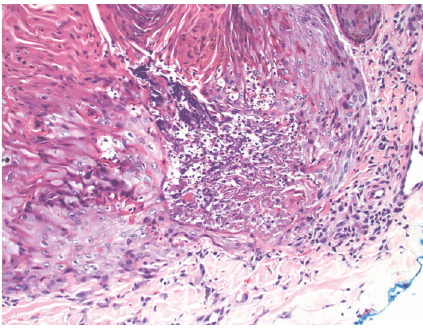
Figure 4: High magnification of the base of the defect showing perforation through the epidermis, and communicating with the superficial dermal collagen (hematoxylin and eosin stain, original magnification ×